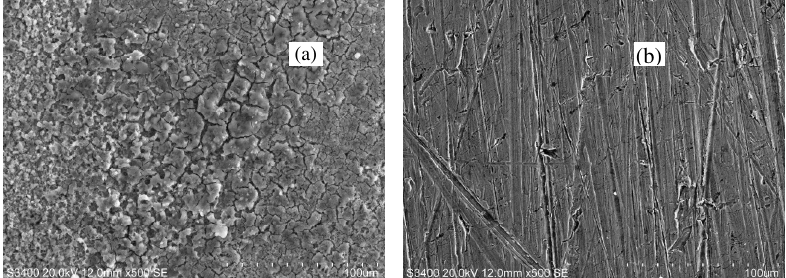
Figure 3. S EM images of MS (a) in 1 N H (200